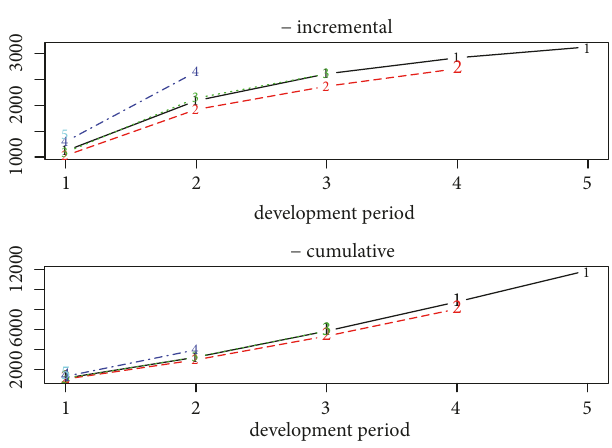
Figure 2: Description of the data (Table